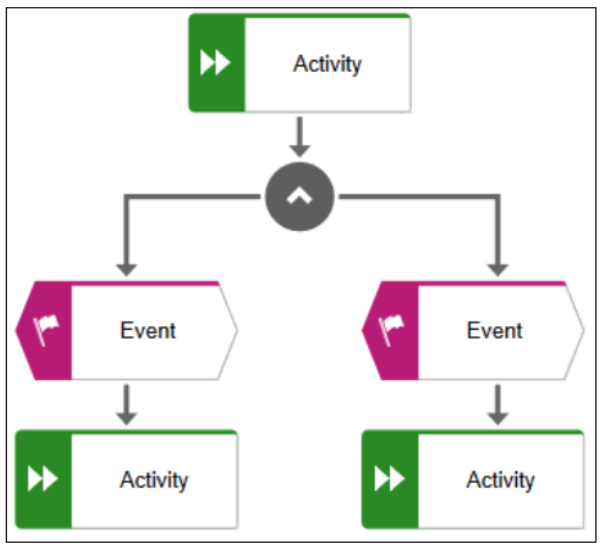
Figure 5. Example of EPC.